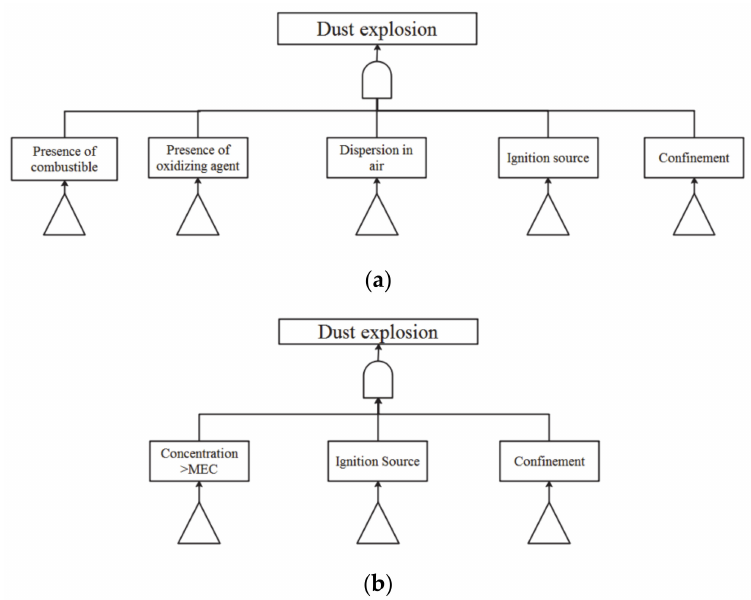
Figure 1. Dust explosion Fault Trees. ( a ) The basic structure based on the dust explosion pentagon; ( b ) The FT structure used for the ROA Plus–ISD.